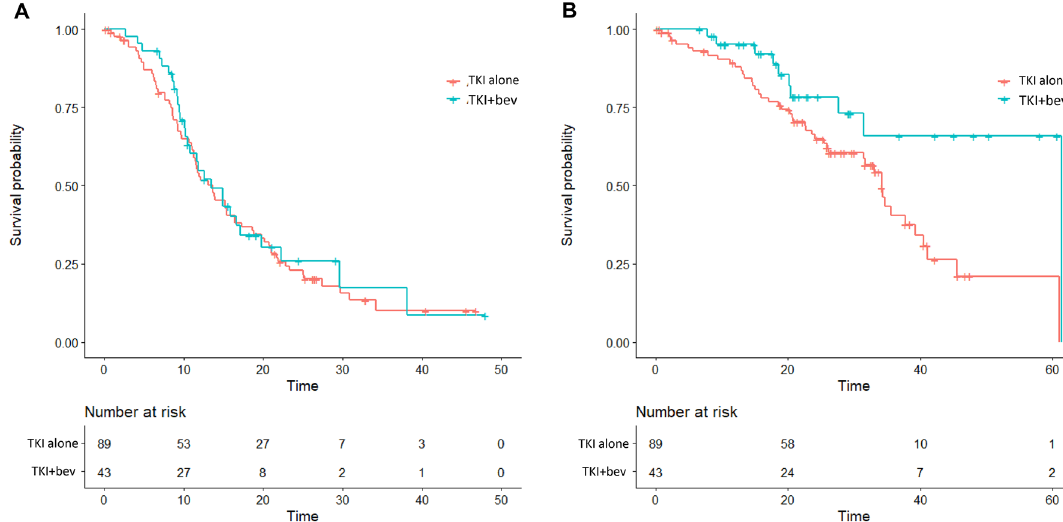
Figure 1. ( A ) PFS and ( B ) OS of EGFR-TKI plus bevacizumab and EGFR-TKI monotherapy groups. bev bevacizumab, TKI tyrosin kinase inhibitor.